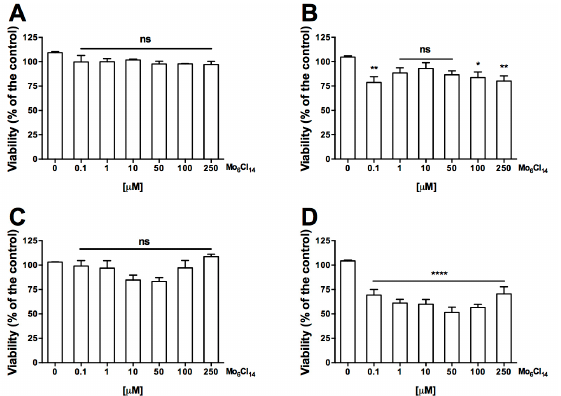
Figure 2. Effect of the cluster on the growth of HepG2 and EA.hy926 cells. The HepG2 ( A , B ) and EA.hy926 ( C , D ) were treated with increasing concentrations (0–250 µ M) for 48 h ( A , C ) and 72 h ( B , D ). Cell viability was measured using the 3-(4,5-dimethylthiazol-2-yl)-2,5-diphenyltetrazolium bromide (MTT) colorimetric assay. Data is expressed as the mean ± SEM from three independent experiments, each performed in triplicate. Statistical differences were assessed by a one-way ANOVA (Kruskal-Wallis) followed by Dunn’s post hoc test. * p < 0.05, ** p < 0.01, **** p < 0.0001 compared with the condition 0 µ